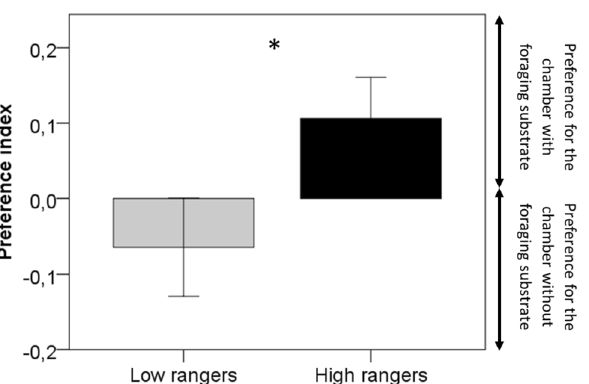
Figure 4. Preference index (PI) during a conditioned place preference task, averaged over three different periods of the production cycle (Period 1: before range access, Periods 2 and 3: after range access), for low (N = 19) and high ranger chickens (N = 21). The PI varied between 1.0 and 1.0. Positive values indicate a preference for the chamber with the foraging substrate, while negative values indicate a preference for